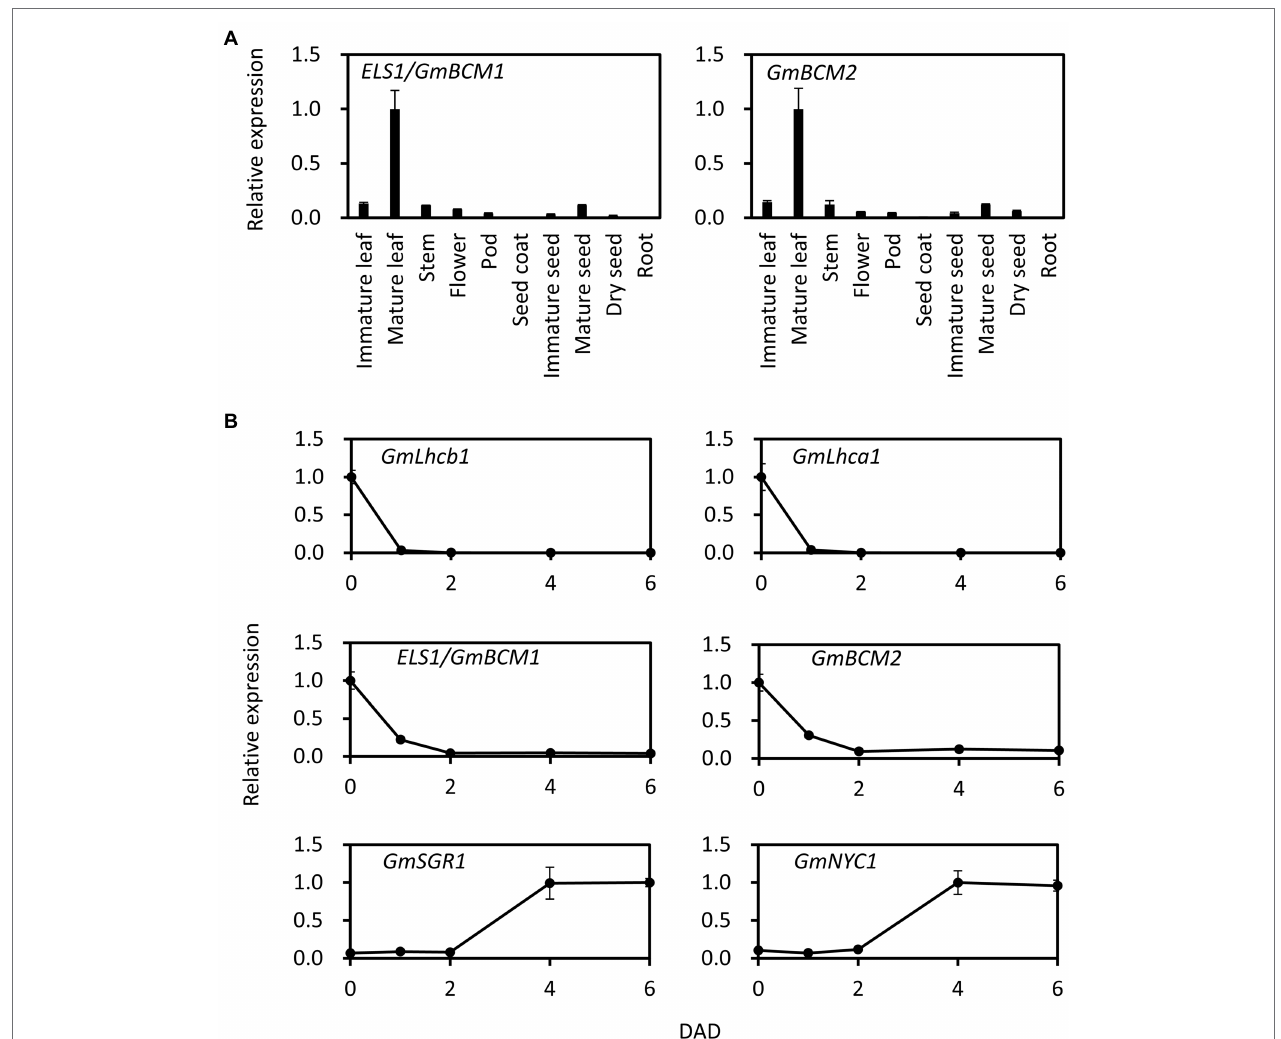
FIGURE 3 | Expression pattern of ELS1/GmBCM1 and GmBCM2 in tissue and during dark treatment. (A) Total RNA from each tissue of WT soybean cultivar Enrei was used for qRT-PCR. (B) Total RNA from primary leaves of WT soybean cultivar Enrei during dark treatment was used for qRT-PCR. Expression levels were standardized using GmACTIN . Error bars indicate the standard error (SE; n = 5 biological